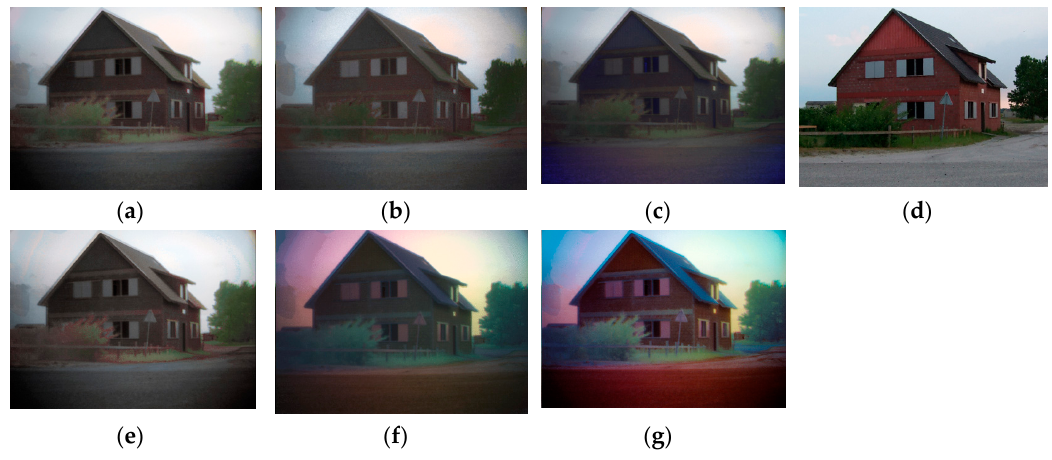
Figure 12. Results from color transformations derived from the standard training set (see Figures 6 and 7) and applied to a different scene in the same environment: ( a ) CTN; ( b ) LFF method; ( c ) SHT method; ( d ) daytime reference (not used for training); ( e ) CTN2; ( f ) statistical color fusion (SCF) method; ( g ) R3DF.